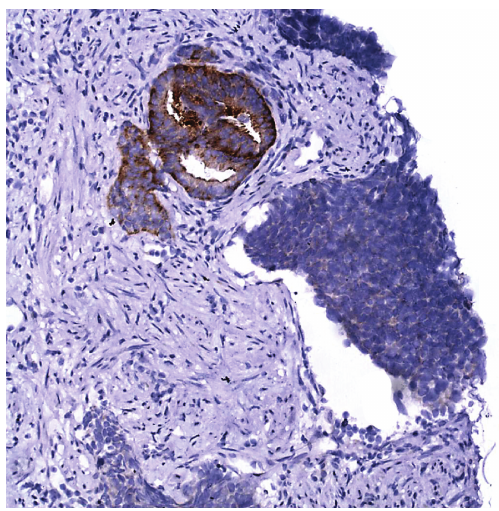
Figure 5: PSA immunostain showing strong positivity in benign prostate glands, whereas the neuroendocrine tumor is faint to absent.